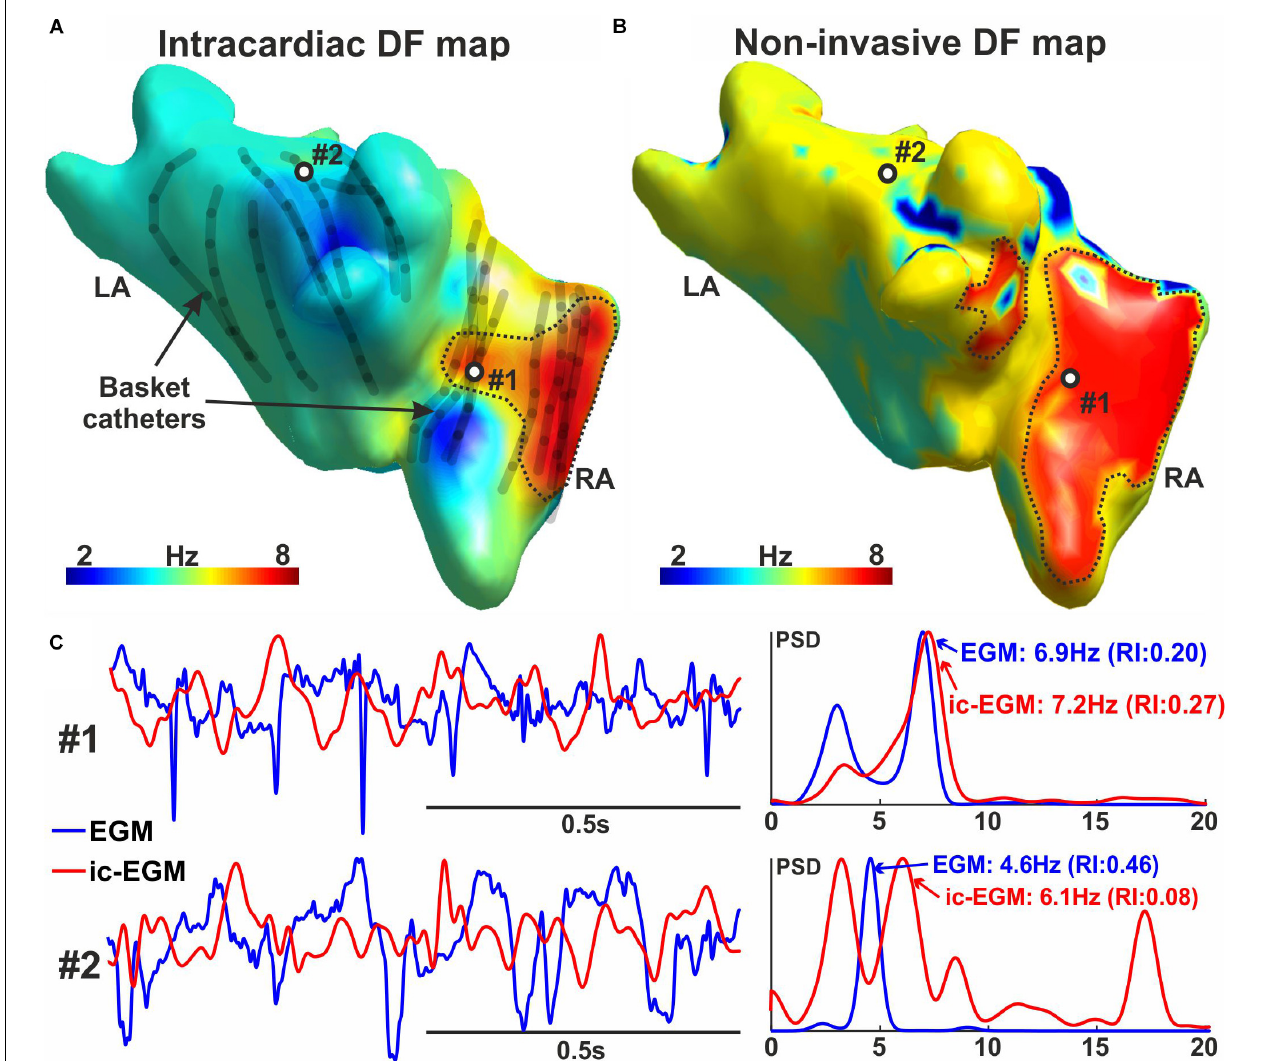
FIGURE 2 | Intracardiac and non-invasive DF map. (A) Intracardiac DF map. (B) Non-invasive DF map. (C) Intracardiac and non-invasive signals and Power Spectral Density (PSD) from points #1 and #2 marked in panels (A,B)